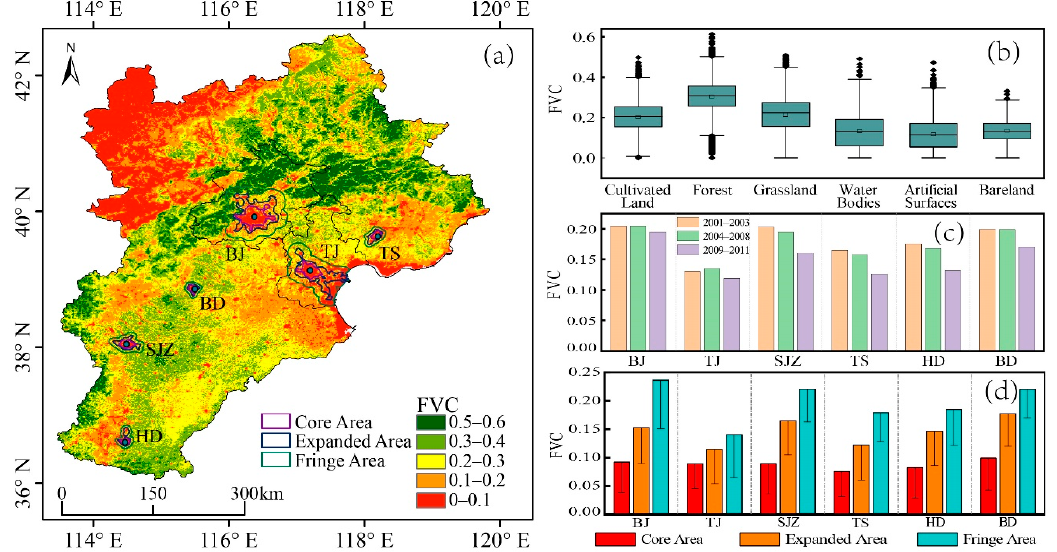
Figure 2. The fractional vegetation cover (FVC) in the BTH region: ( a ) average FVC from 2001 to 2011; ( b ) box plots of FVC values of different land covers; ( c ) average FVC of six large cities from 2001 to 2003, 2004 to 2008, and 2009 to 2011; and ( d ) average and standard deviation of FVC in the core, expanded, and fringe areas of six large cities.